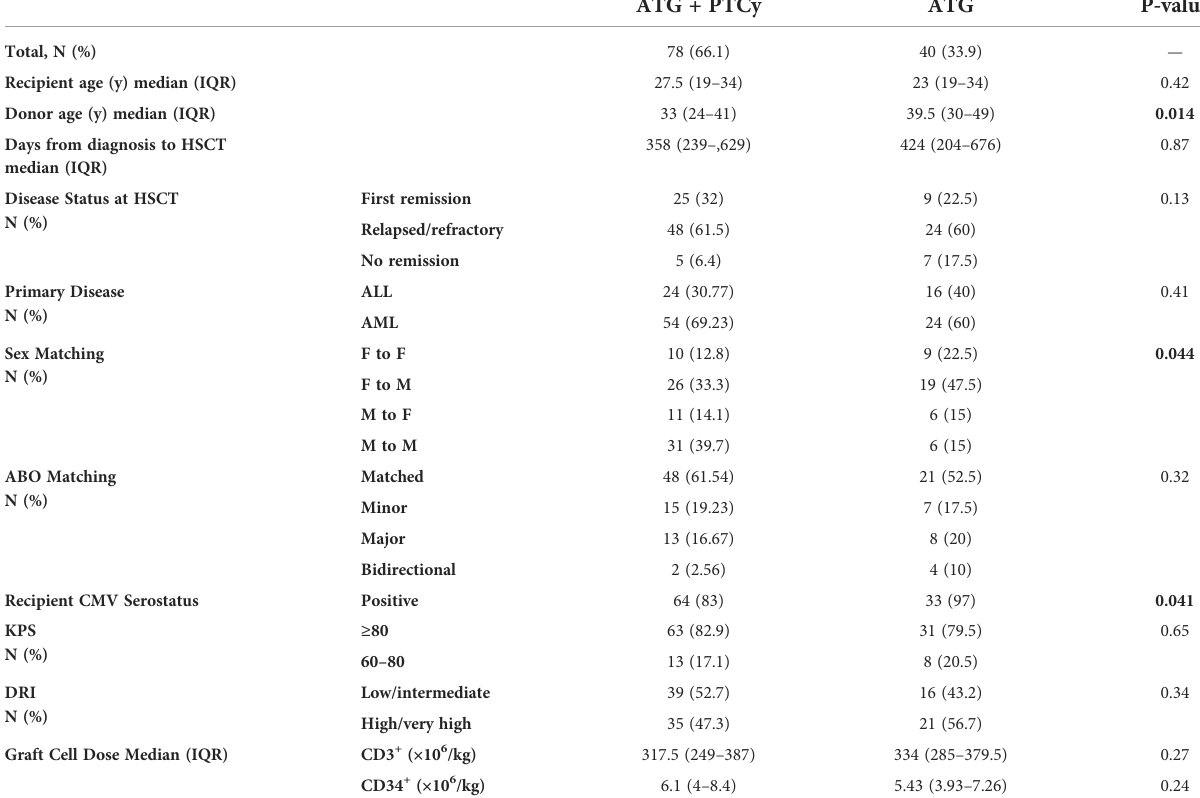
TABLE 1 Baseline demographic, clinical, and laboratory characteristics of patients and their comparative evaluation according to treatment groups. ATG + PTCy